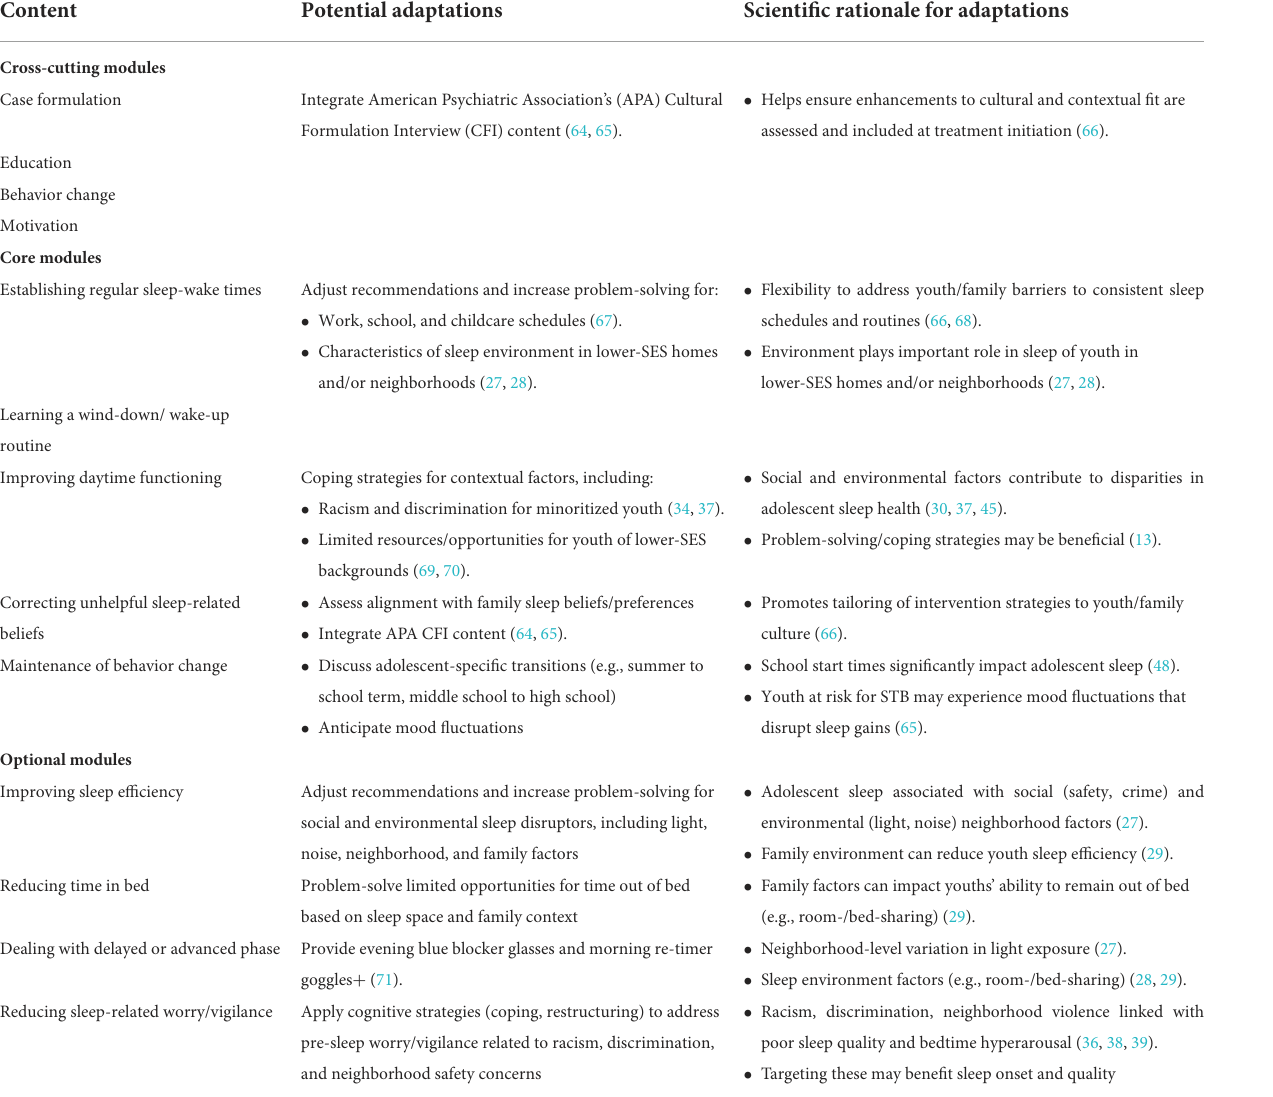
TABLE 1 TSC intervention content, potential adaptations, and scientific rationale for adaptations. Content Potential adaptations Scientific rationale for